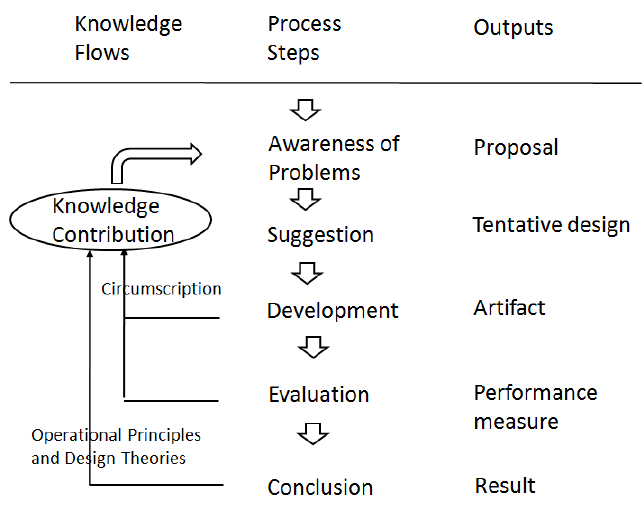
Figure 4. A design science process model adapted from